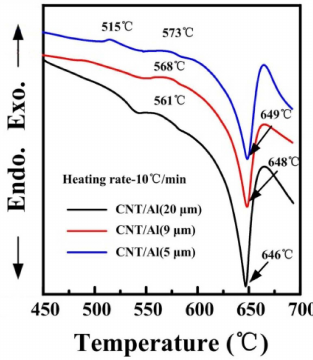
Figure 9. DSC plots of CNT/Al (with powder size of 20 µ m), CNT/Al (with powder size of 9 µ m) and CNT/Al (with powder size of 5 µ m) composite powders that were ball milled for 24